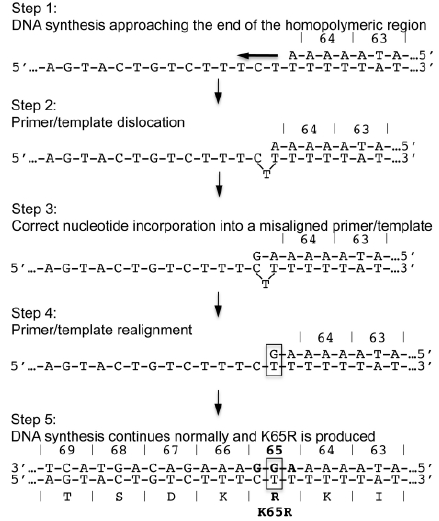
Figure 2. Schematic of dislocation mutagenesis and the development of the K65R mutation in subtype C HIV-1. Step 1 : DNA synthesis approaches the end of